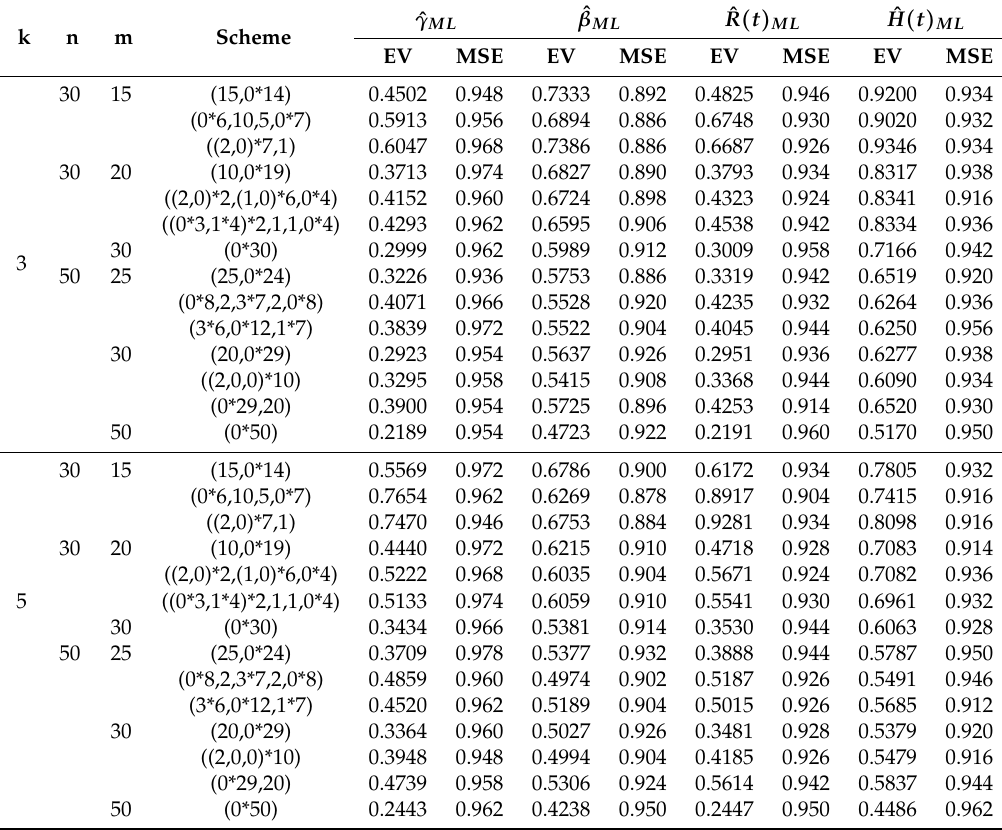
Table 20. Average length and coverage probability of 95% asymptotic confidence/Bayesian credible interval for parameters under SELF using noninformative priors when γ = 0.3, β = 0.8, t = 1.5, a 1 =